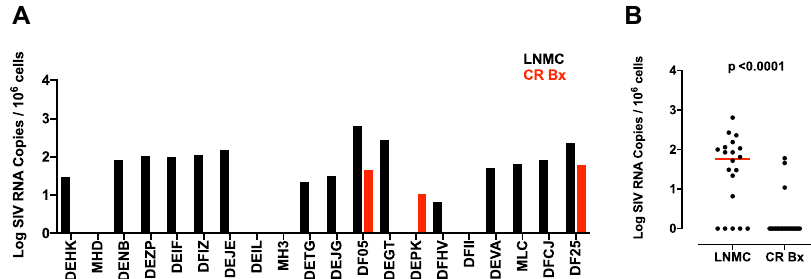
Fig. 8 Viral RNA in lymph node and colorectal biopsies of long-term ART suppressed monkeys. A Log SIV RNA copies/10 6 cells are shown from lymph node mononuclear cells (LNMCs) derived from lymph node tissue (black bars) and colorectal biopsies (red bars) from 20 rhesus monkeys chronically infected with SHIV-SF162P3 and ART-suppressed for 3 years. Each bar represents the SIV viral load of the monkey listed in the indicated tissue site as the log of SIV RNA copies/10 6 cells. B Viral RNA persistence in lymph nodes from monkeys under 3 years of ART suppression. Each dot is a monkey ( n = 20). The median is displayed as a red line. p value is derived from a two-tailed Mann-Whitney U test. LNMC, lymph node mononuclear cells, CR Bx, colorectal Quantitative RT-PCR viral RNA and quantitative PCR viral DNA assays . A of both standards and samples was done using Superscript III VILO, following the manufactorer ’ s instructions (Invitrogen). RT-PCR assays were run in duplicate and Quantitative RT-PCR assay was used to measure plasma viral loads and tissue- qPCR assays were run in triplicate in 96 well MicroAmp Fast Optical plates associated SIV RNA and a quantitative PCR (qPCR) viral DNA assay was used to (ThermoFisher) on the Quantstudio 6 Flex system (Applied Biosystems) using the determine cellular viral copies 63 . SIV gag RNA standards were generated using the following thermocycle settings: 95 °C for 20 s for initial denaturation, and 95 °C for AmpliCapMax ™ T 7 High Yield Message Maker Kit (Cell Script) and puri fi ed with 1 s followed by 60°C for 20 s repeated for 45 cycles. All primers used are listed in RNA clean and concentrator kit (Zymo Research, CA, USA). Log dilutions of the Supplementary Table 2. For the qPCR assay, RPP30 speci fi c primers and probes RNA or SIV gag standards were included with each RT-PCR assay and an RPP30 were used from the RPP30 copy number assay Hs00922551_cn (ThermoFisher, control was included in viral DNA qPCR assay. For RT-PCR, reverse transcription